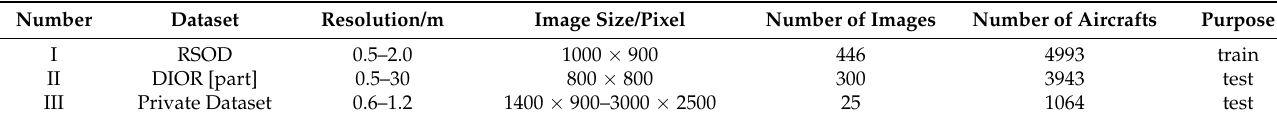
Figure 5. Object detection dataset subsets. ( a ) Dataset I. ( b ) Dataset II. ( c ) Dataset III. Table 2. Information of image